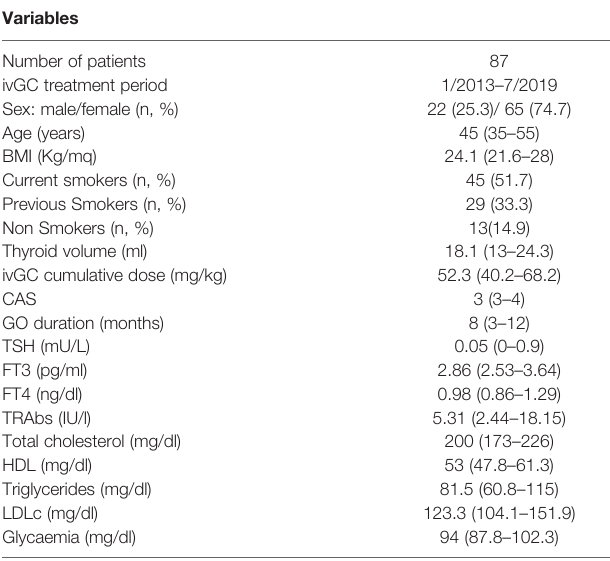
TABLE 1 | Characteristics of patients at study